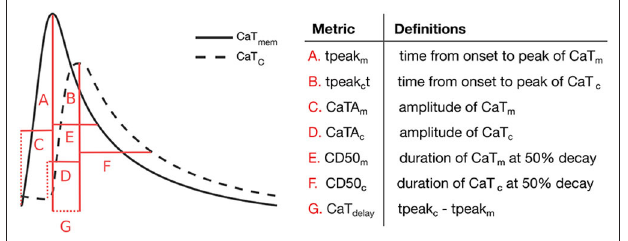
FIGURE 3 | Ca 2 + transient metrics defined to compare peripheral and central CaT traces, and corresponding descriptions.